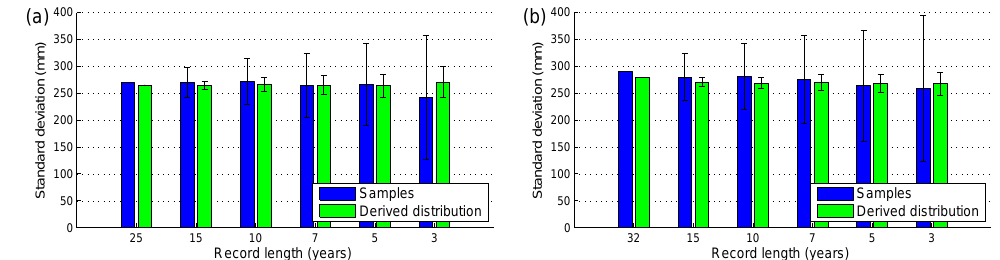
Figure 9. Sample standard deviations of annual precipitation computed from yearly totals (in blue), compared to the corresponding population standard deviations estimated with the DD approach (in green). For record lengths (cid:54) 15 years, the whiskers show the range ± 1SD from resampling ( n = 200). Concepción is on (a) and Lugano on (b) .